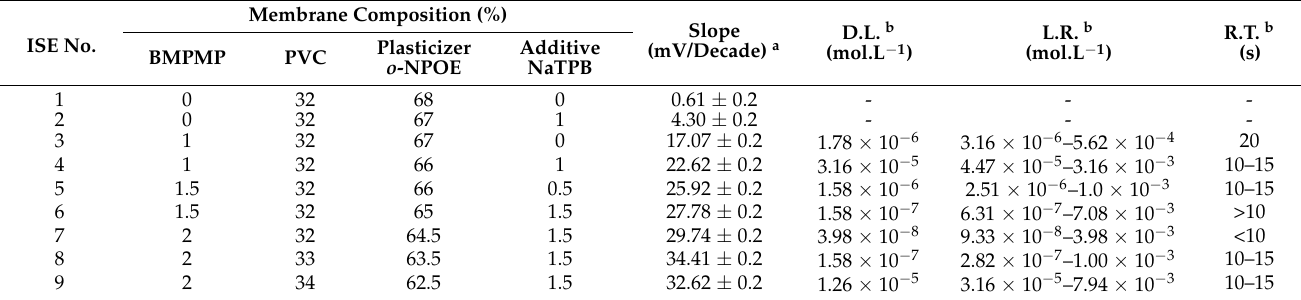
a All slope values reported represent the mean and ± SD of three measurements. b D.L., L.R., and R.T. denote the lower detection limit, linear working range and response time respectively. The results are based on three replicate